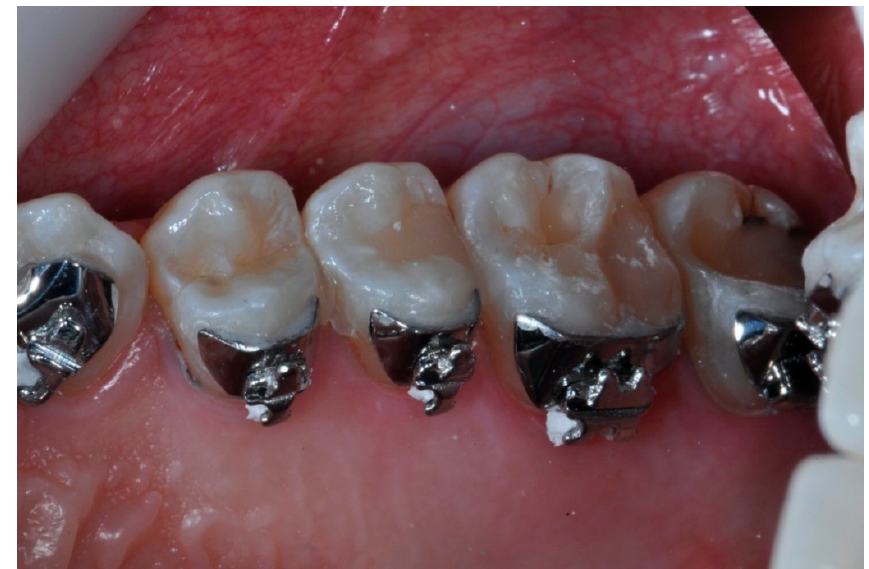
Figure 3. Brackets in place; before composite excess